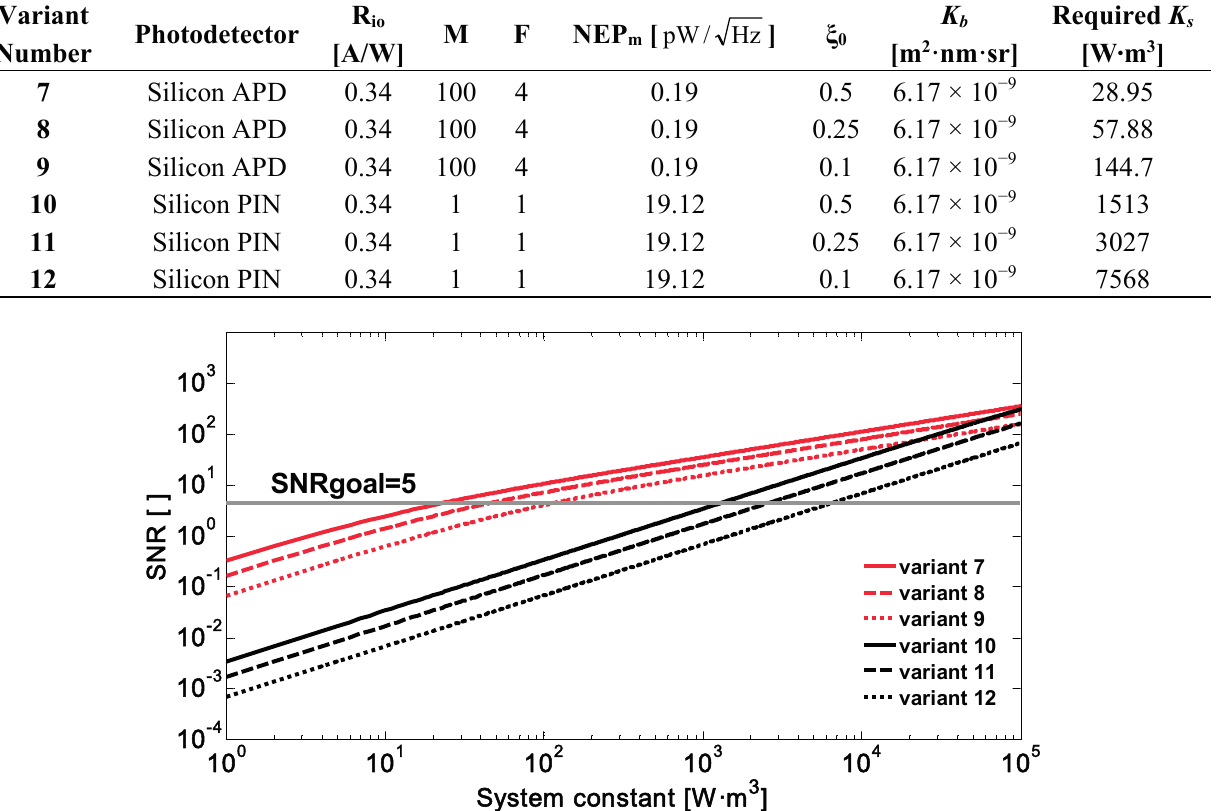
Figure 3. Signal-to-noise ratio vs. system constant due to a spray drift cloud located at 500 m for variants 7 to 12 (Table